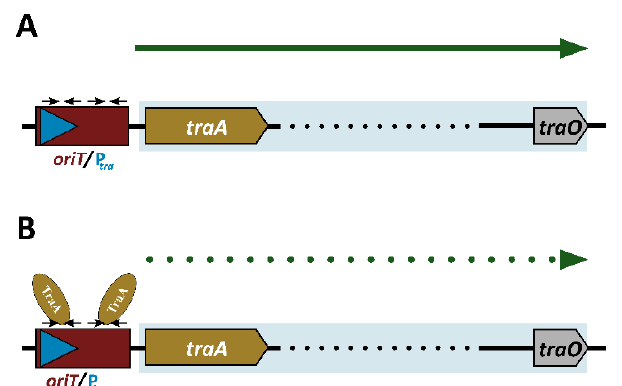
Figure 4. Regulation of the pIP501 main conjugation promoter P tra by the TraA relaxase. Schematic views of the activity of promoter P tra without ( A ) and with ( B ) relaxase-mediated repression. The TraA relaxase binds to two inverted repeat sequences (black horizontal arrows), overlapping with the P tra promoter region, thereby controlling the expression of the conjugation operon (genes traA to traO ), as indicated by the green dotted line.